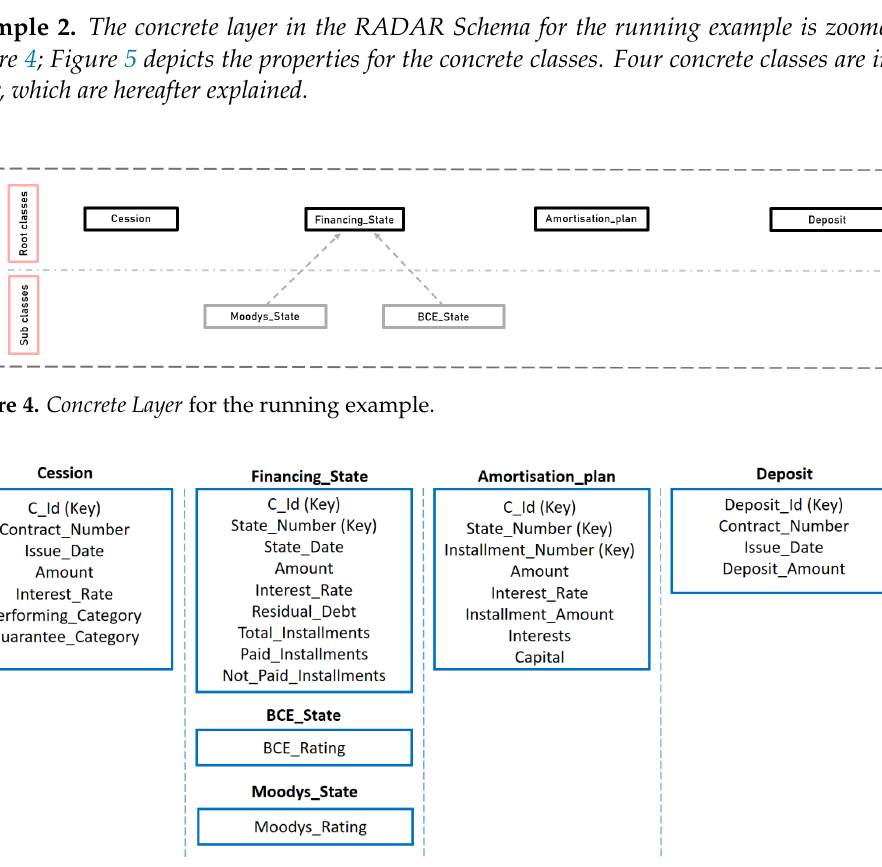
Figure 5. Properties of concrete classes in the RADAR Schema for the running example (depicted in Figure